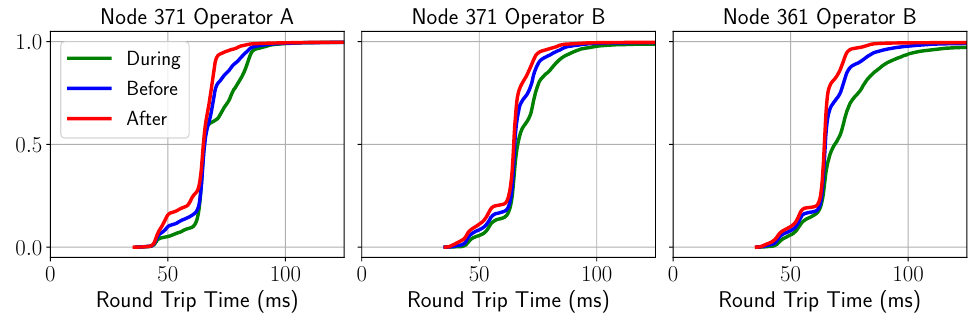
Figure 8. CDF of ping behavior before/during/after the